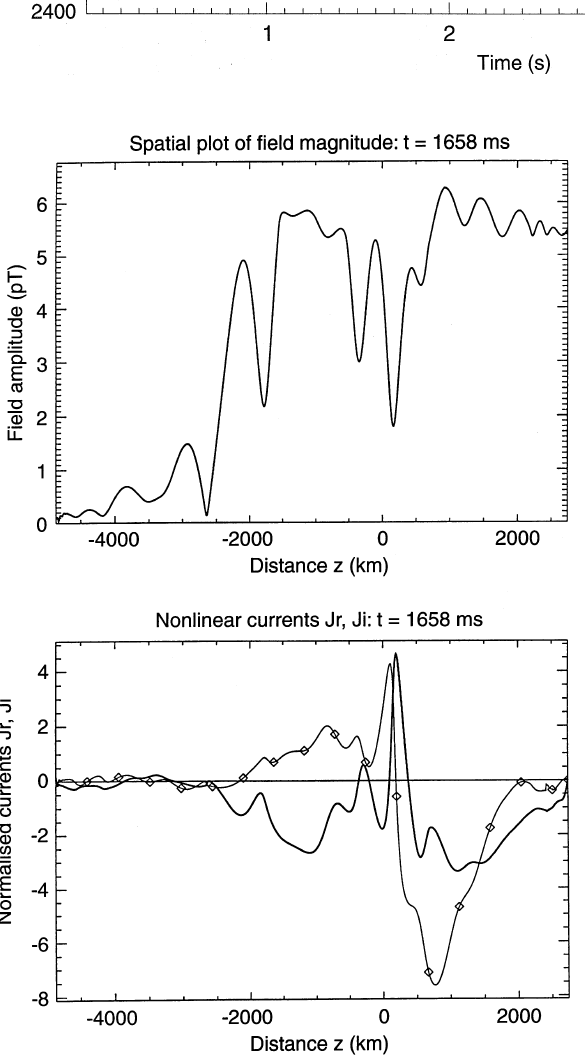
Fig. 21. Case D. Snapshot of the GR at t = 4146 ms. This GR is clearly of the riser